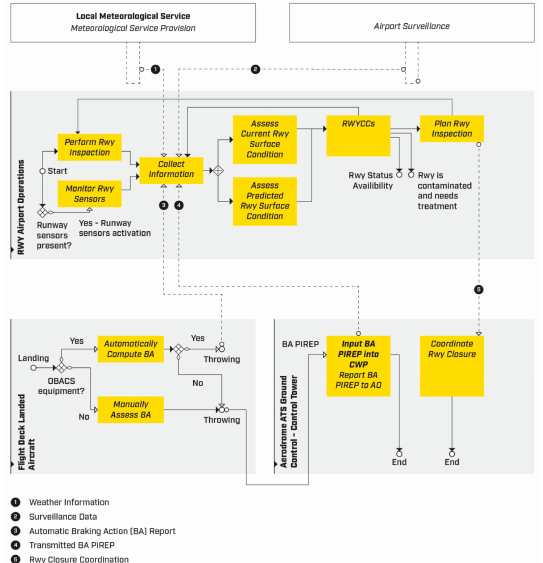
Figure A1. The new conceptual method for elaboration of the runway surface condition status based on the outputs of SESAR Pj03b-06